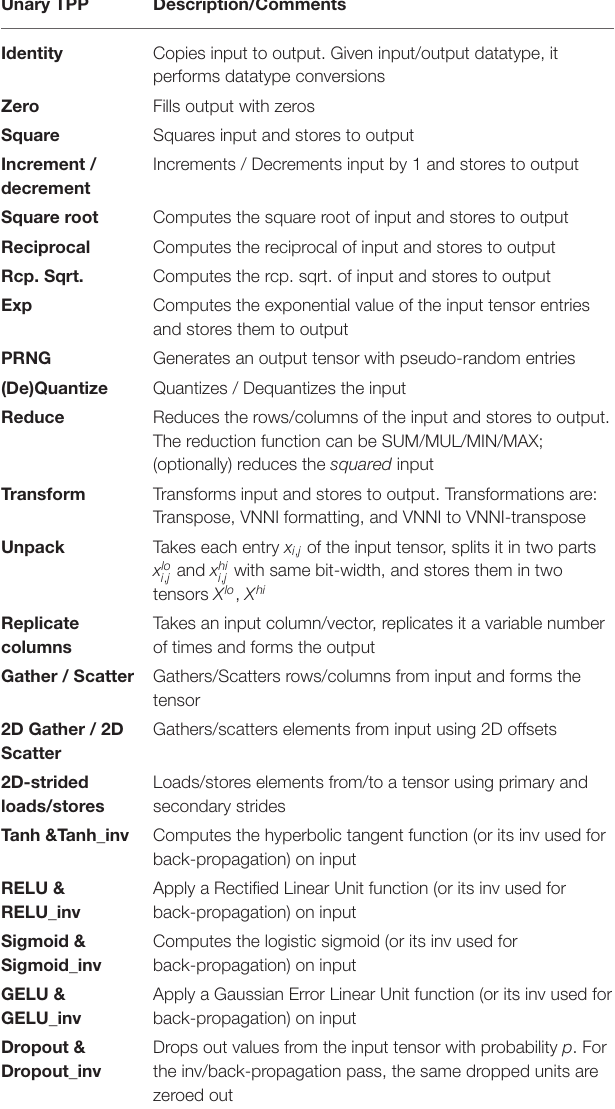
Description/Comments